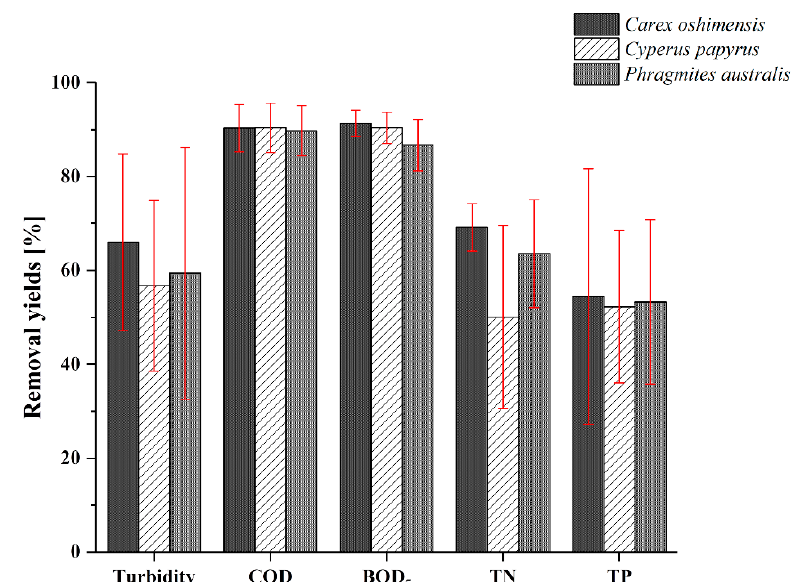
Figure 3. Removal yields of main chemical and chemical–physical contaminants by Carex oshimensis , Cyperus papyrus and Phragmites australis . The red bars indicate the 95% confidence intervals.